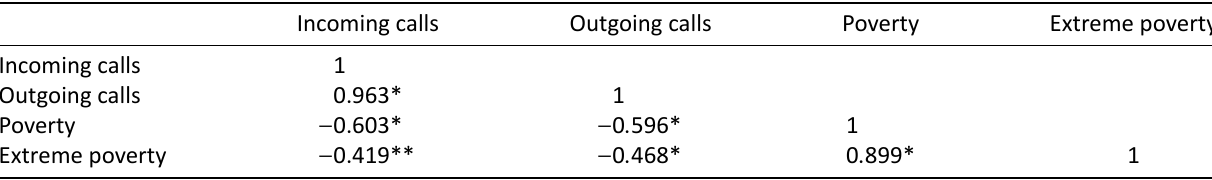
Figure 3. Average number and direction of inter-district calls per capita for each poverty category. Source: Authors. Table 3. Correlations between poverty levels and calling